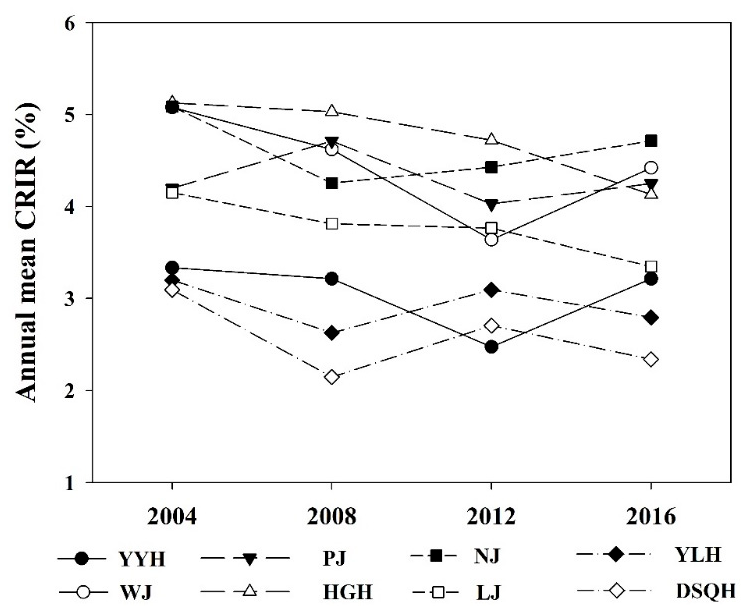
Figure 12. Annual mean variation of the CRIR in basin-pairs in the four climatic zones in Guangdong.